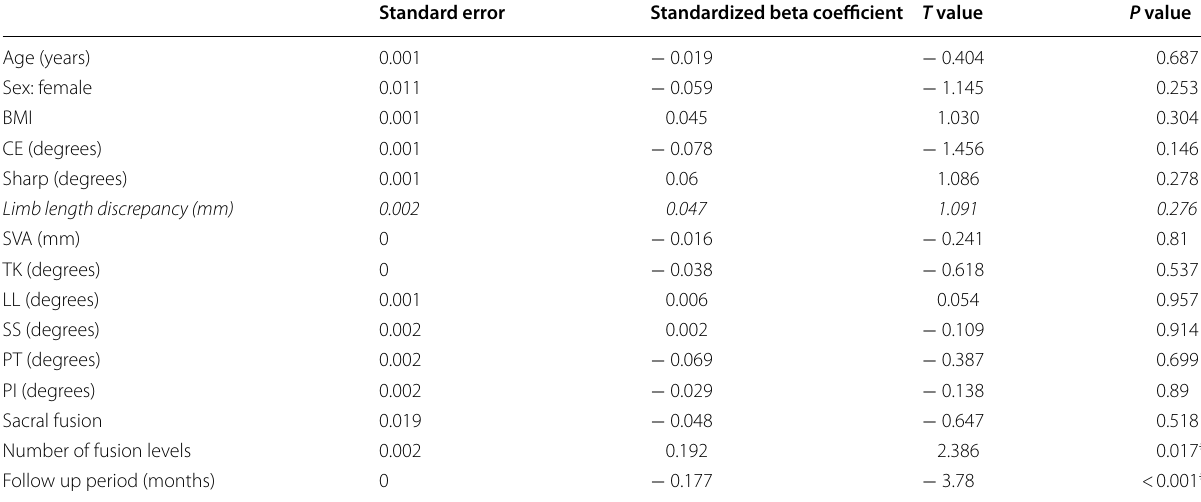
Table 3 Results of linear multiple regression